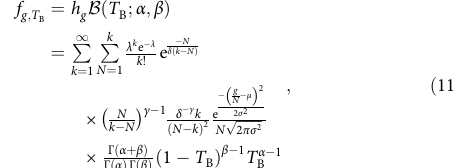
The experimental pro fi les were captured for each junction over time, for three replicate experiments, and their averages are shown in Fig. 3 and Supplementary Fig. 1. The sorting index . The diffusion solution for the bacterial concentration along the branches of the T-maze (Eq. (2)) was approximated by a linear superposition of 1- e (cid:1) d 2n = ð 4 Dt Þ ffiffiffiffiffiffiffi D diffusion solutions, B n = B 0 2 n 4 π Dt